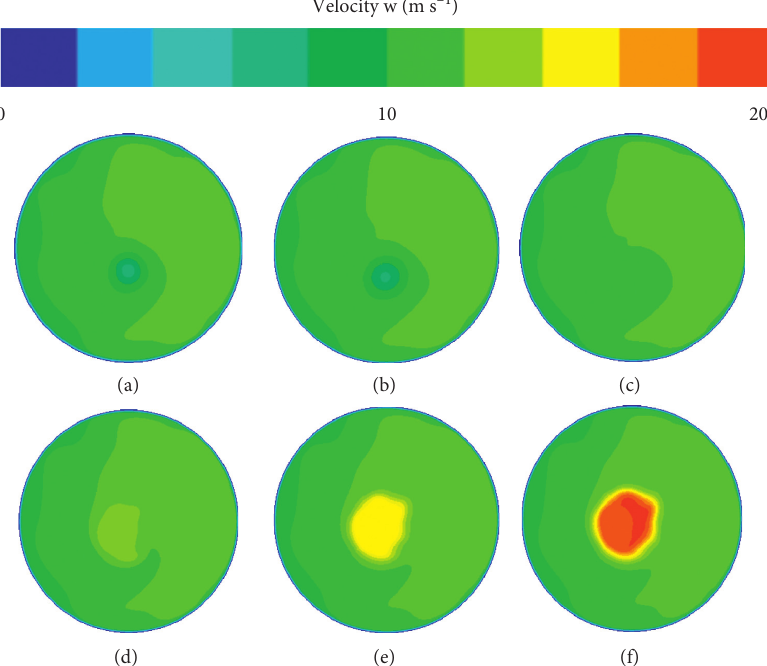
Figure 9: Axial velocity distribution cloud diagram of the nozzle. (a) Original device, (b) v � 16 (m s − 1 ). (f) v jet